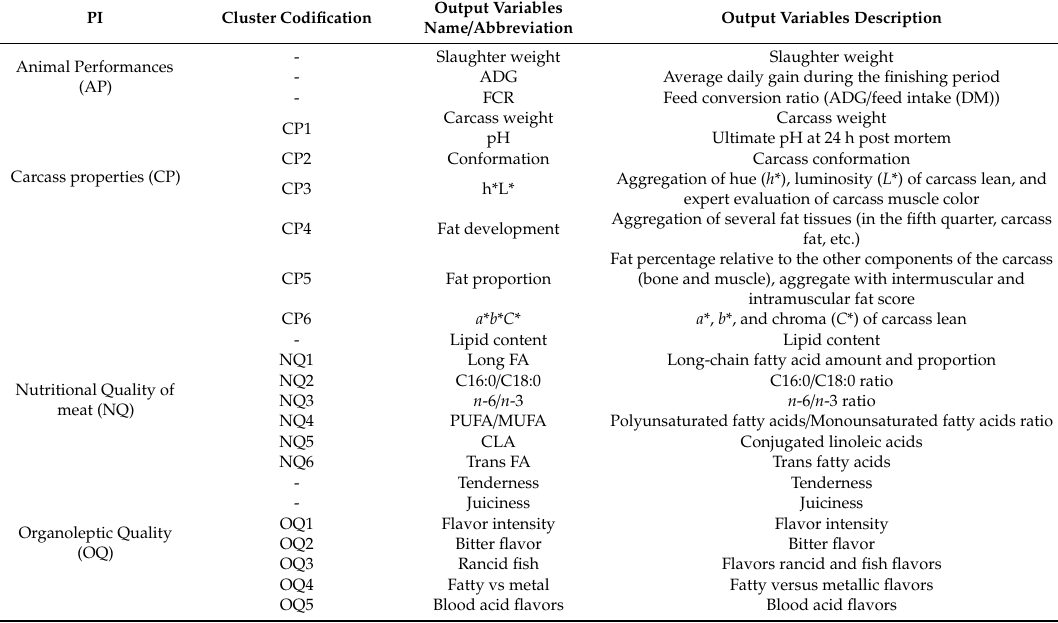
Table 2. Output variables of the pre-treatment operation describing the four parameters of interest